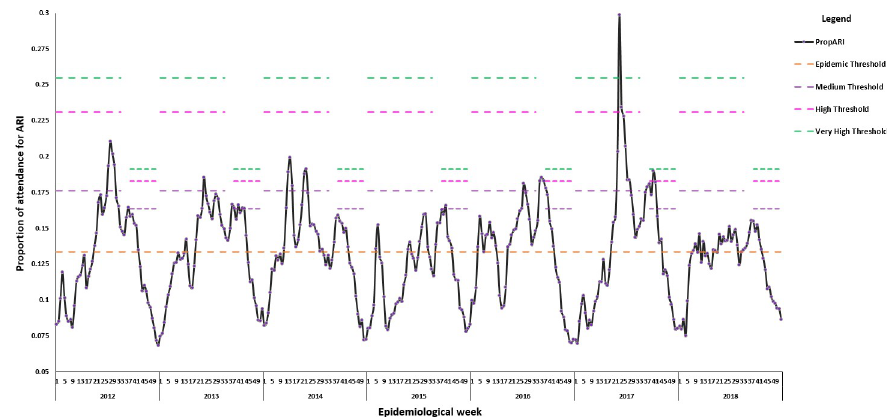
Fig 4. Time series for the two wave curve of the proportion of attendance for ARI using WHO Average Curve Method, Mauritius, season 2012–2018.